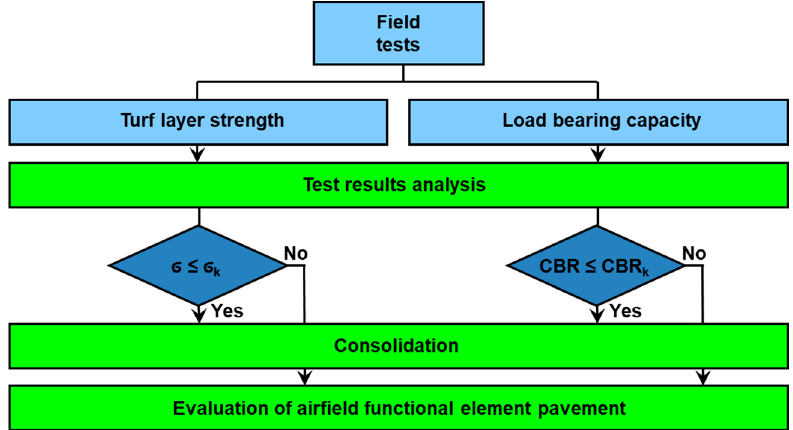
Figure 8. Procedure during the assessment of the technical condition of natural airfield pavements using the APCI method.